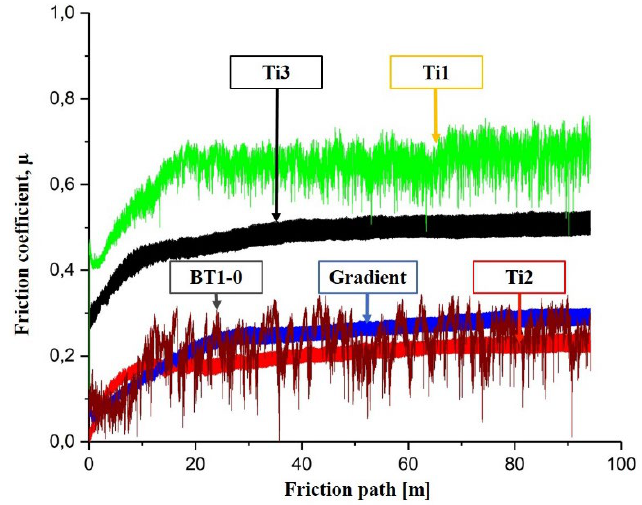
Figure 9. Results of tribological tests of coatings obtained by detonation spraying.